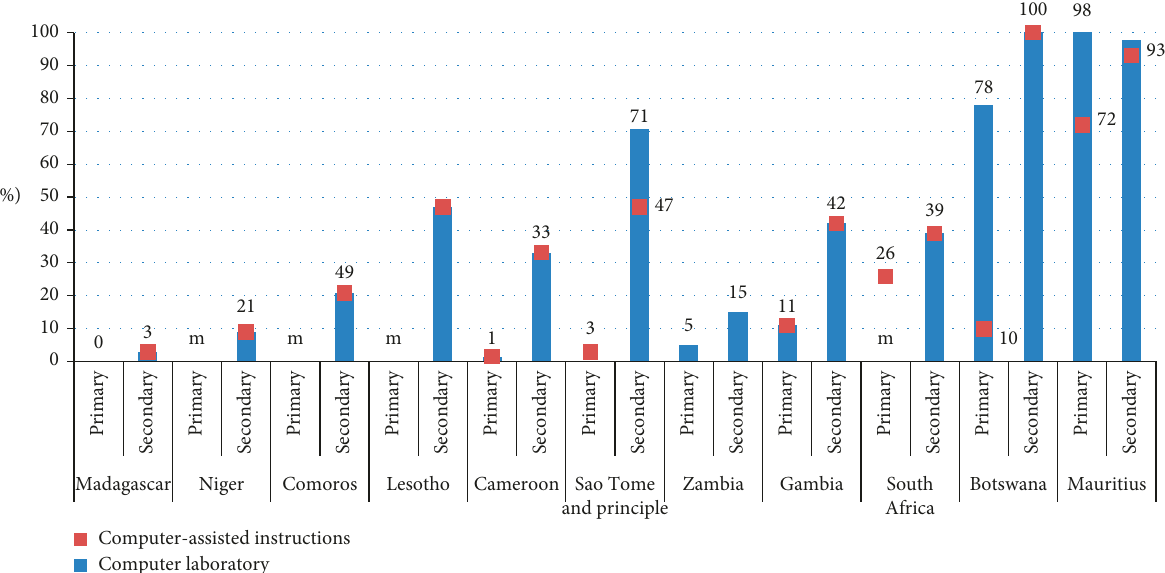
Figure 2: Computer-assisted instruction and laboratories in primary and secondary education (adapted from [35], under the creative commons attribution license/public domain).